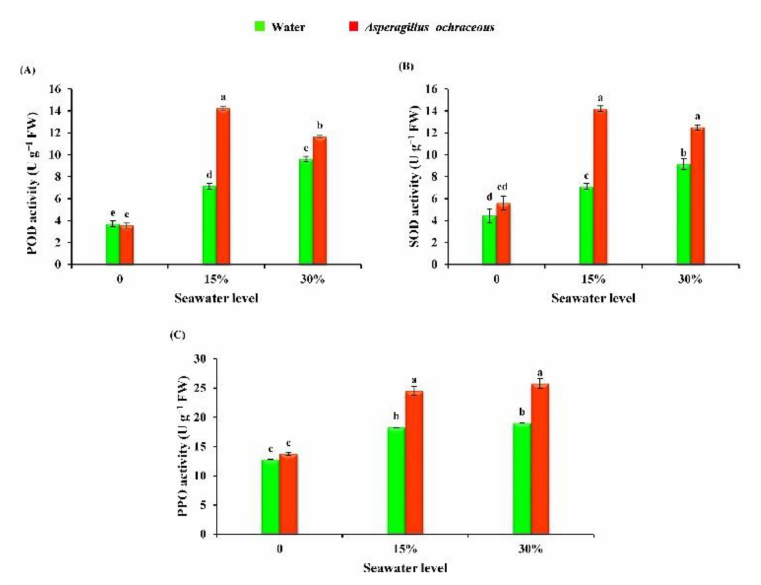
Figure 6. Effect of seawater irrigation, A. ochraceus application, and their interactions on the activity of antioxidant enzymes of barley plants {( A ) POD, ( B ) SOD, and ( C ) PPO}. Each bar represents the mean ± standard error. Different letters indicate significant differences between the treatments according to an LSD test at p < 0.05. FW: Fresh weight.